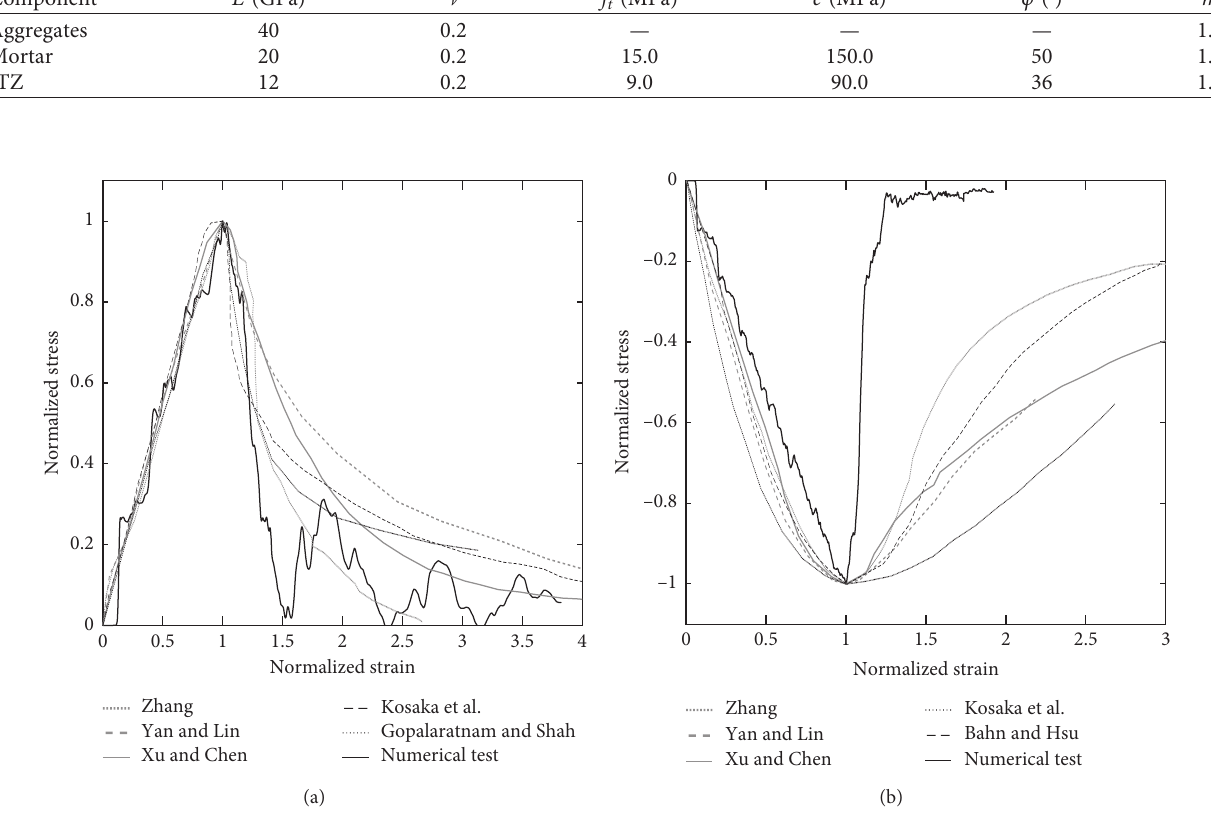
Figure 5: Comparison of the normalized stress-strain responses of concrete: (a) normalized tension; (b) normalized